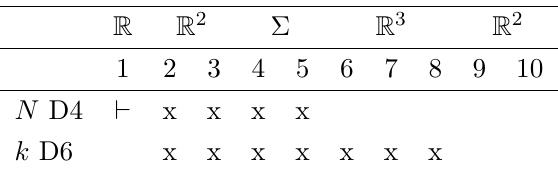
Table 3. Type IIA setup in which Nahm poles arise as boundary conditions on the X i triplet of D4